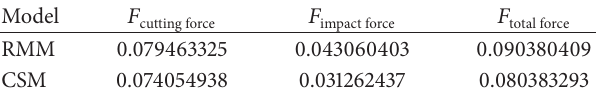
Table 5: The cutting and impact forces of each model induced by the pressure